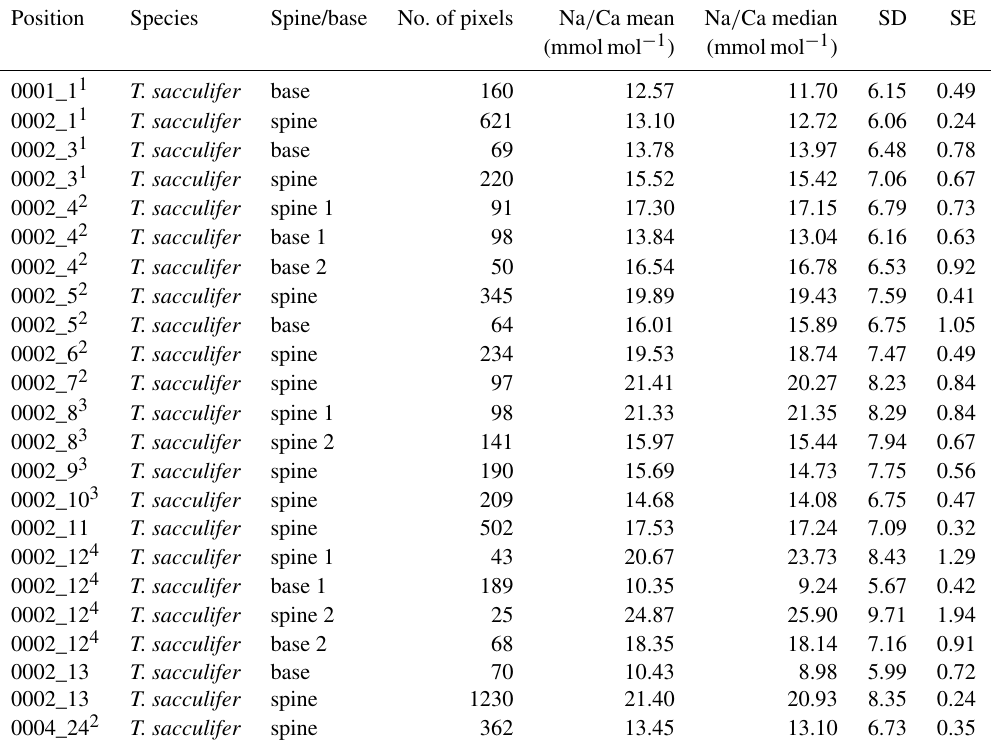
Table 4. Overview of spine and spine base Na / Ca values for T. sacculifer multi-nets. Similar superscript numbers indicate that these are measurements from the same